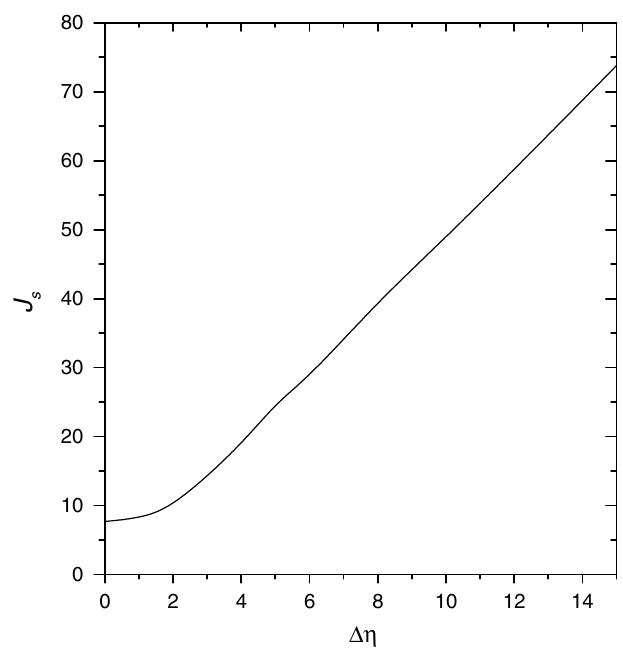
FIG. 3. Dimensionless start current J spread (cid:1) (cid:14) , for Q ¼ 0 and (cid:15)L ¼ 0 . Here, reflections at the ends of the grating are